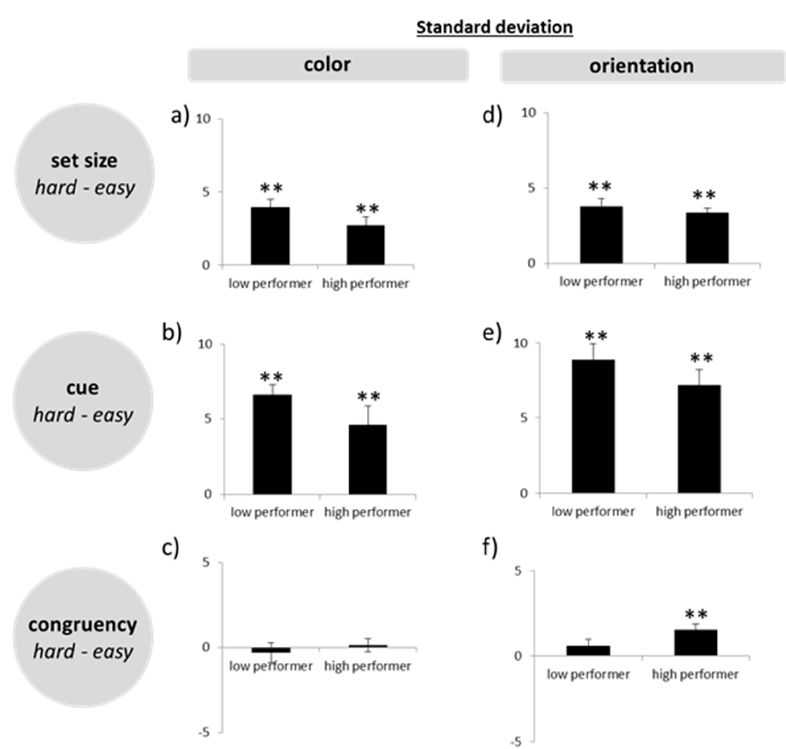
Figure 4. Difficulty scores (standard deviations easy–hard) from the precision task for color ( a – c ) and orientation ( d – f ) separated for each task condition (set size, cue, congruency). ∗∗ = p ≤ 0.01.